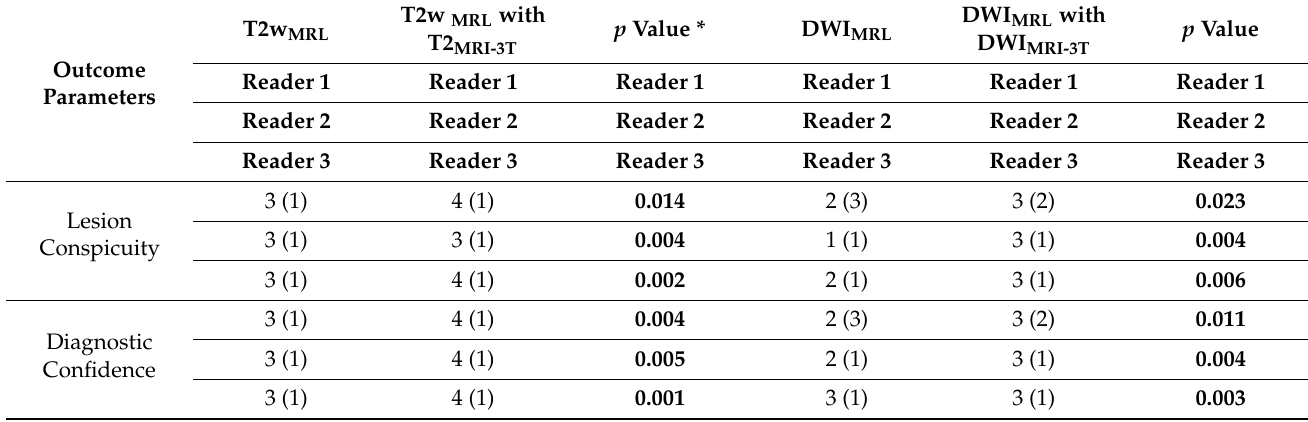
Table 4. Comparison of lesion conspicuity and diagnostic confidence on MR-Linac (MRL) alone and on MRL in consensus with the MRI 3T (MRL with MRI 3T ).